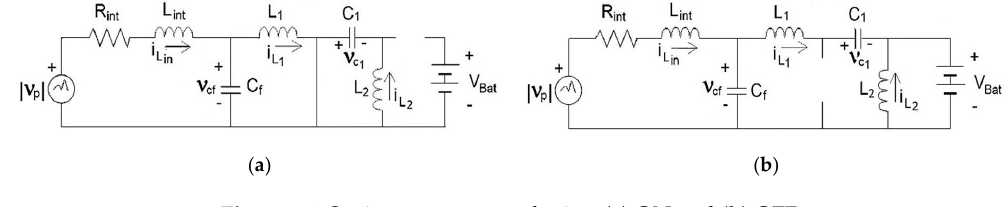
Figure 14. Sepic converter topologies: ( a ) ON and ( b ) OFF.